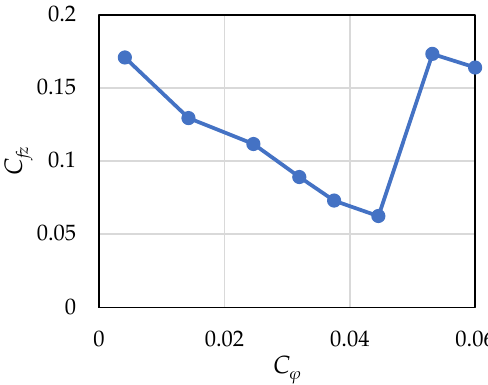
Figure 10. Variation of axial force with flow rate.